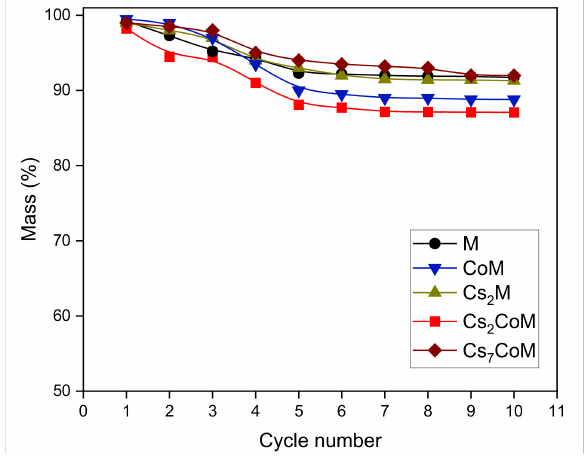
Figure 1. Mechanical stability test of active films coated on monoliths.